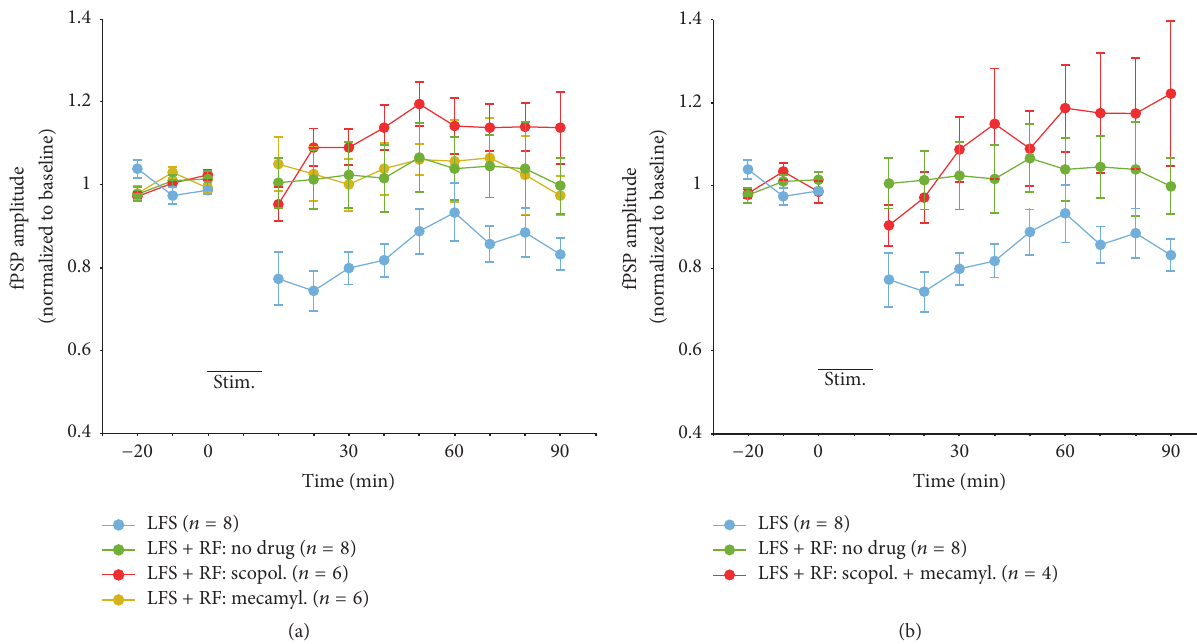
Figure 3: Amplitude of fPSPs recorded in V1 in response to single pulse stimulation of the LGN in urethane-anesthetized rats. (a) Application of LFS (stim.) to the LGN resulted in significant depression of fPSP amplitude (the same group as in Figure 1), an effect that was blocked by pairing LFS with RF stimulation (LFS + RF; the same group as in Figure 1). The effect of RF stimulation to block LTD was not affected by administering (20min prior to the onset of baseline recordings) either scopolamine (scopol., 1mg/kg, i.p.) or mecamylamine (mecamyl., 0.5 mg/kg, i.p.). (b) A combination of both drugs at very high doses (scopol., 10mg/kg + mecamyl., 5 mg/kg) also failed to reverse the block of LTD elicited by pairing LFS with RF